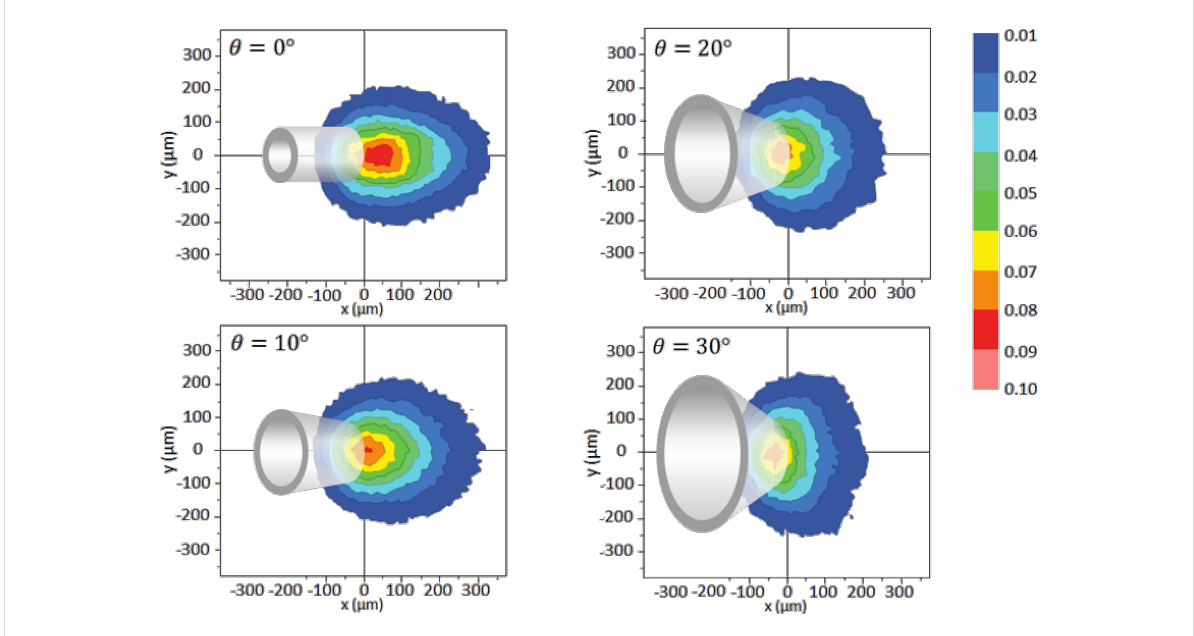
Figure 7: Precursor flux distributions at the substrate under molecular flow conditions for conical nozzles with cone angles, θ , varying from 0° (straight tube) to 30°. The (0,0) position denotes the upper edge of the nozzle. J tot is the total molecule flow leaving the nozzle exit and the color code indi- cates the molecule fraction J / J tot . The cone geometries are shown to illustrate which areas are covered and hence inaccessible by the electron beam.